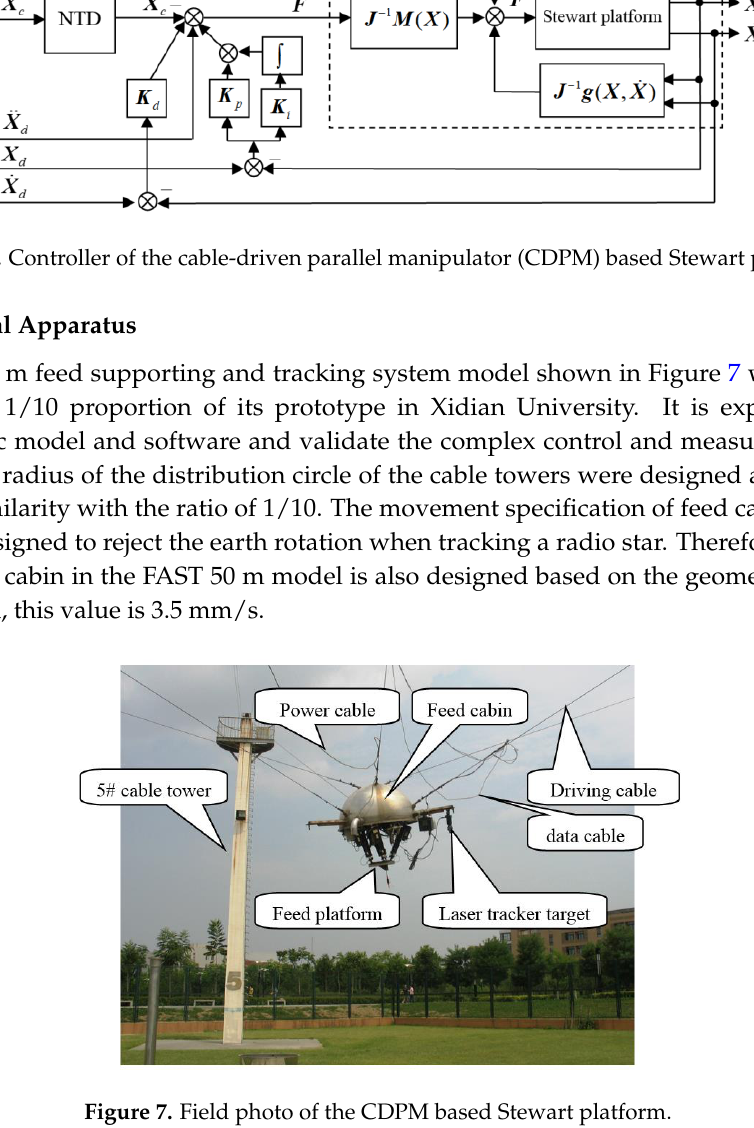
Figure 7. Field photo of the CDPM based Stewart platform.